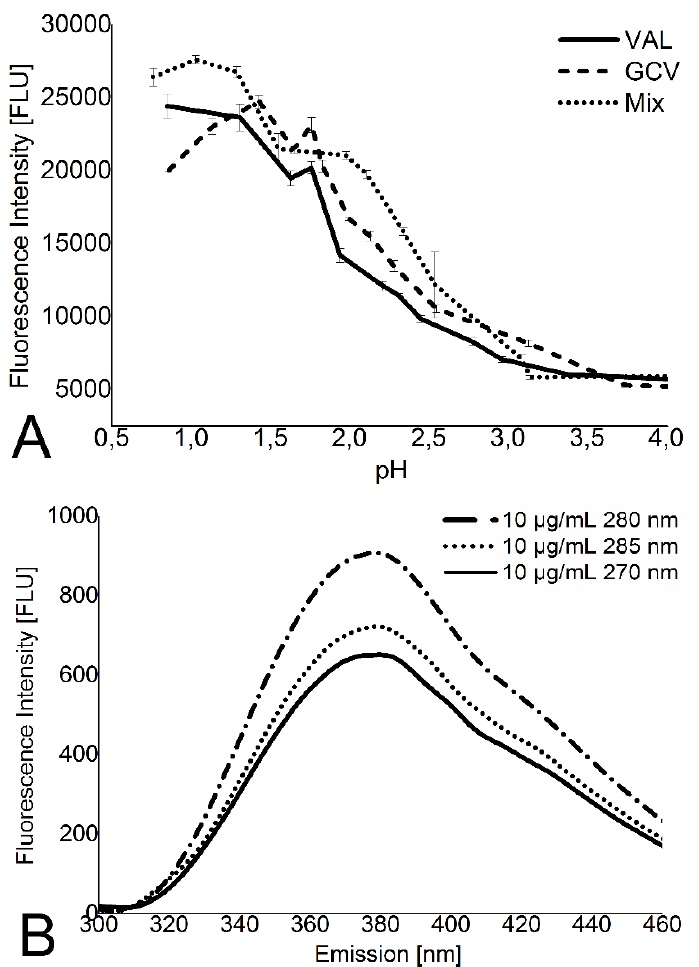
Figure 1. Optimization for parameters for fluorescence measurement. ( A ) Equimolar concentrations of valganciclovir (VAL) and ganciclovir (GCV) as well as a 1:1 mixture (Mix) were tested for pH-dependent fluorescence change. Valganciclovir and ganciclovir seem to overlap at a pH value close to 1.2 and close to 3.6. The overlap close to pH 1 has the higher fluorescence intensity of the two pH values; ( B ) Enlarged emission spectrum of valganciclovir at 10 µg/mL showing the global maximum for different excitation wavelength. Different 96-well plate materials were tested to minimize autofluorescence. polystyrene showed an autofluorescence signal of 302 ± 8.2 fluorescence units (FLU) at the measurement wavelength, which is 1.7 times higher than the noise fluctuations of the detector. Autofluorescence of the polypropylene